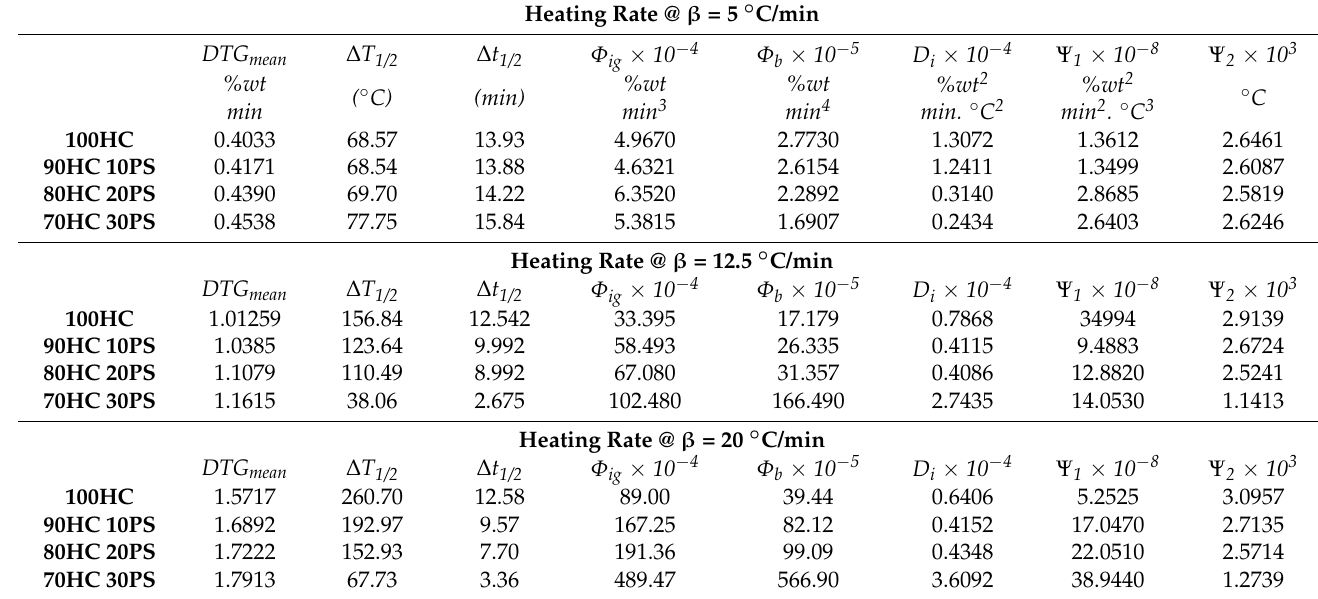
Table 4. Derived combustion parameters from TG and DTG curves for various fuel blends in air